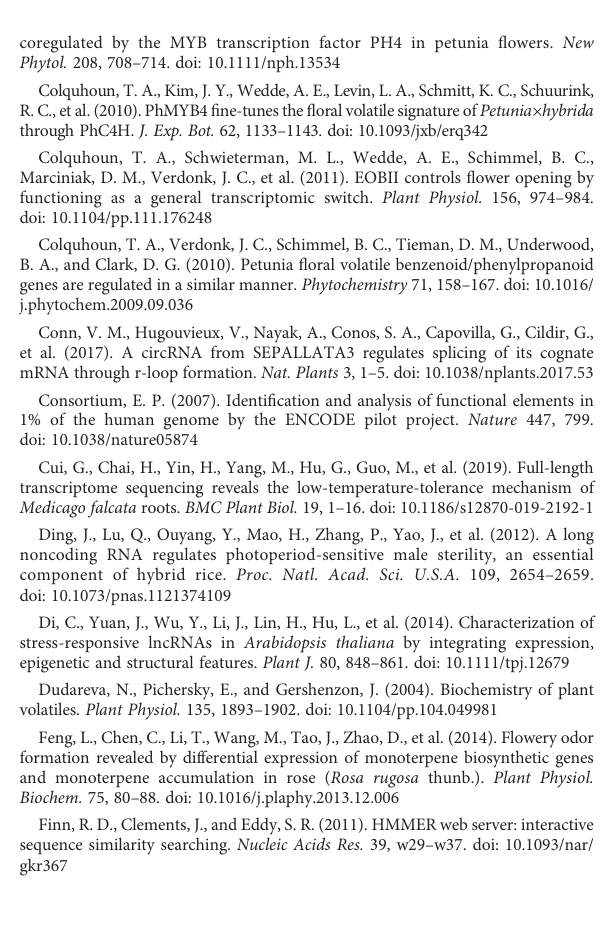
SUPPLEMENTARY FIGURE 1 qRT-PCR validation of selected lncRNAs expression across fl owering stages in rose ‘ Tianmidemeng ’ . Expression levels of selected transcripts measured by qRT-PCR and RNA-Seq are showed in the same histograms. Black columns indicate relative gene expression levels detected by qRT- PCR (left y-axis; normalized units). Grey columns represent expression determined by RNA-Seq in RPKM units (right y-axis). SUPPLEMENTARY FIGURE 2 Associations between module and fl oral volatiles by WGCNA analysis. Each row corresponds to amodule eigengene, columnto atrait. Each cell contains the corresponding correlation and p-value. The table is color- coded by correlation according to the color